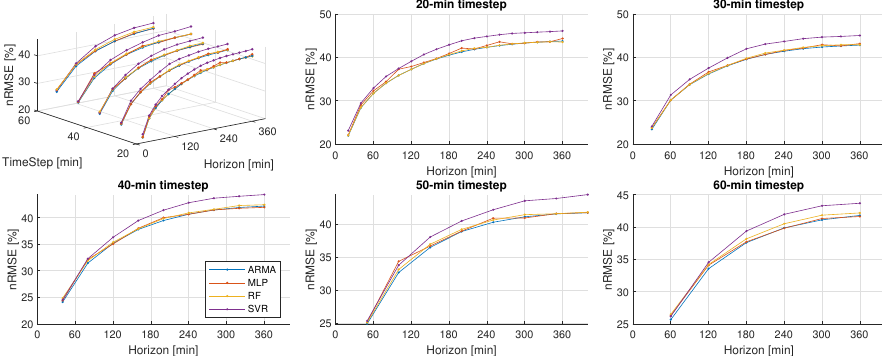
Figure 4. Comparison of the forecasting models for different time-steps and horizons at